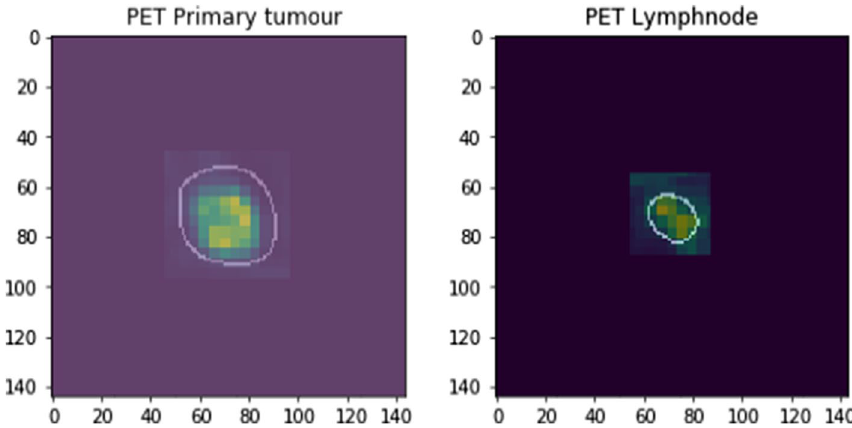
Fig. 1 Example of the input data. Each input dataset consisted of a manually segmented primary tumour and a manually segmented lymph node. All data were padded with zeros to have the same size of 144 144 144 × ×